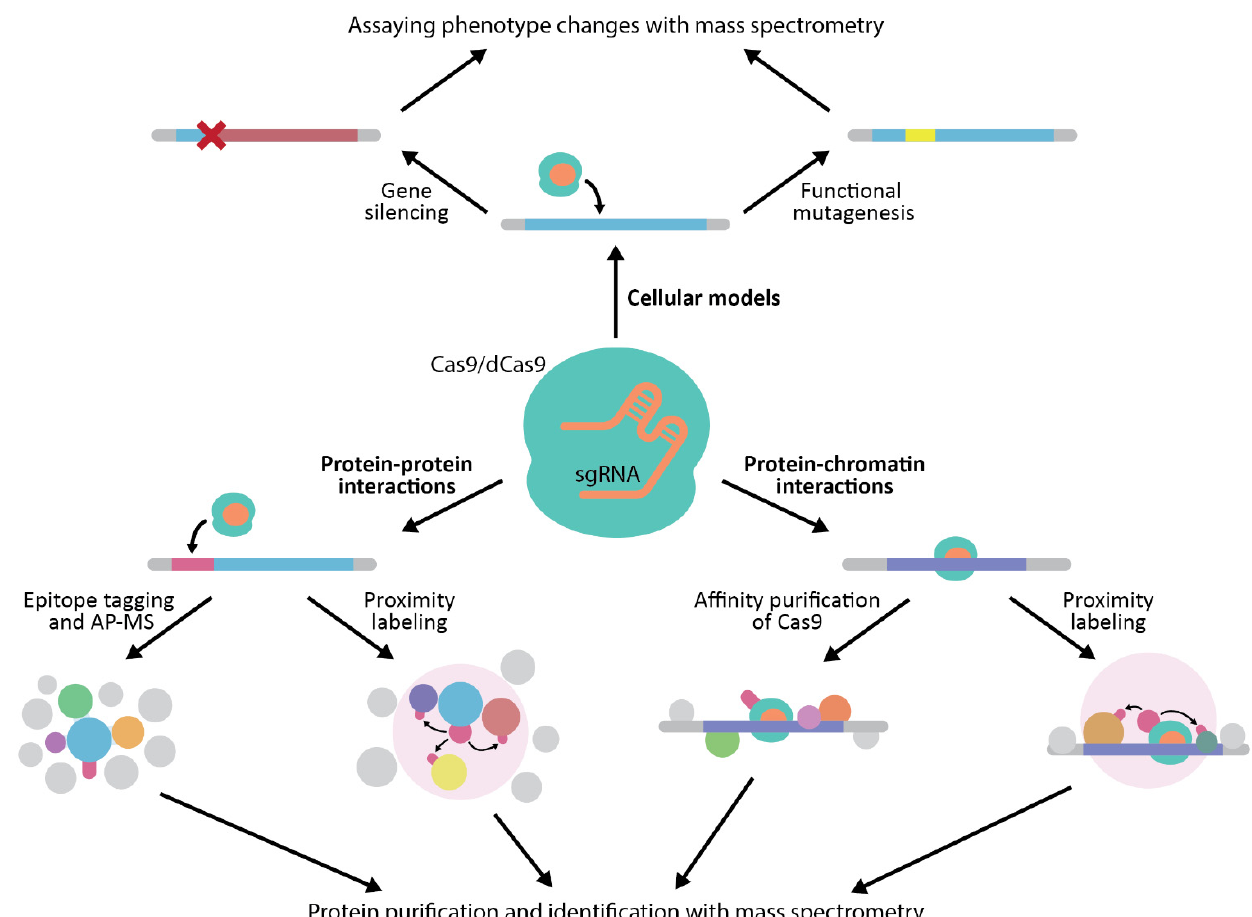
Figure 2. An overview of applications of CRISPR-Cas to proteomics experiments.